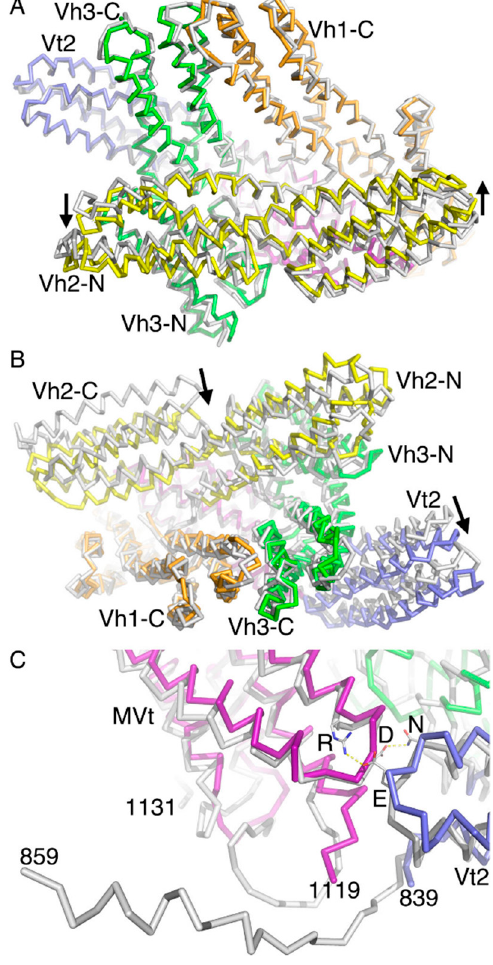
Figure 5. Inter-domain distinctions between the H1’-parallel metavinculin conformers. ( A ) Superposition of both Vh1 subdomains (Vh1-N and Vh1-C, residues 2–250) and the MVt (residues 975–1114) domain from our two H1’-parallel metavinculin cryogenic electron microscopy structures. The 4.15 Å H1’-parallel metavinculin conformer has its domains colored spectrally (Vh1, orange; Vh2, yellow; Vh3, green; Vt2, blue; MVt, violet) and the 4.27 Å H1’-parallel metavinculin conformer is shown in gray. Several subdomains are labeled, and the relative movements of the two Vh2 subdomains are indicated. ( B ) Superposition of the Vh1 (residues 2–250) and MVt (residues 975–1114) domains from our H1’-parallel metavinculin cryogenic electron microscopy (colored spectrally) and crystal (subunit A, shown in gray) structures. Several subdomains are labeled, and relative subdomain movements are indicated. ( C ) Superposition of the Vh1 (residues 2–250) and MVt (residues 975–1114) domains from our H1’-parallel metavinculin cryogenic electron microscopy (colored spectrally) and crystal (subunit B, shown in gray) structures. The crystal structure has residues through 859 for VH and 1131 for MVt, while the cryogenic electron microscopy structure has residues built through 839 for VH and 1119 (labeled) for MVt. Subunit B residues Asn-773, Glu-775, Asp-1042, and Arg-1046 are also labeled by their respective amino acid one letter codes (N, E, D, R).